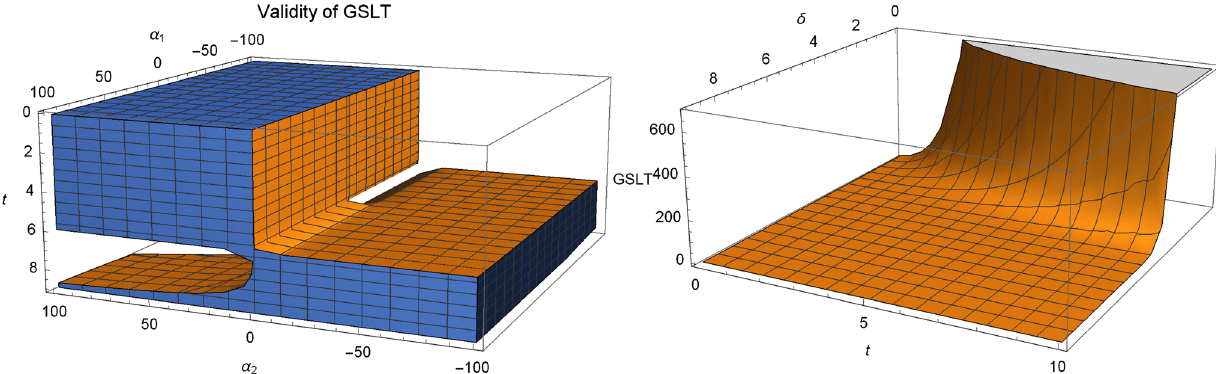
Fig. 2 Left plot represents the regions where GSLT is satisfied for δ = 10 and right graph corresponds to evolution of GSLT versus δ for α